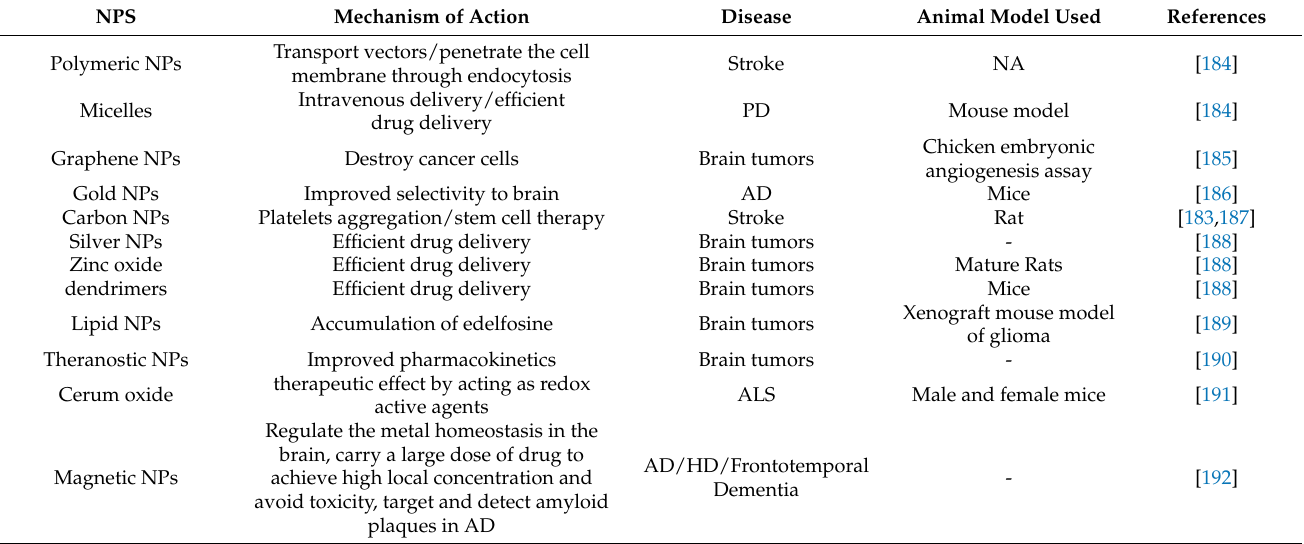
Table 2. Different types of nanomaterials with their mechanism of